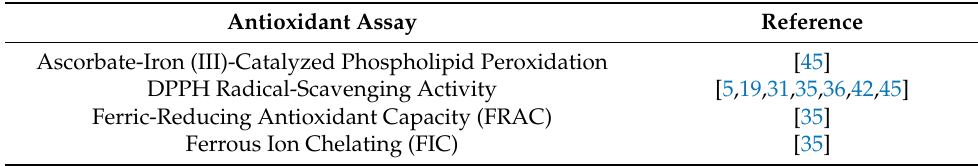
Table 6. Antioxidant assays tested Origanum syriacum ’s